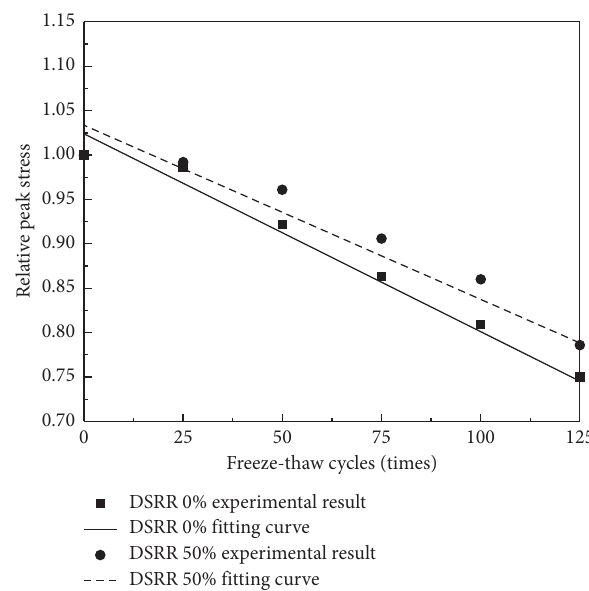
) and μ . (a) OC. (b) DSC with 50% DSRR. 0